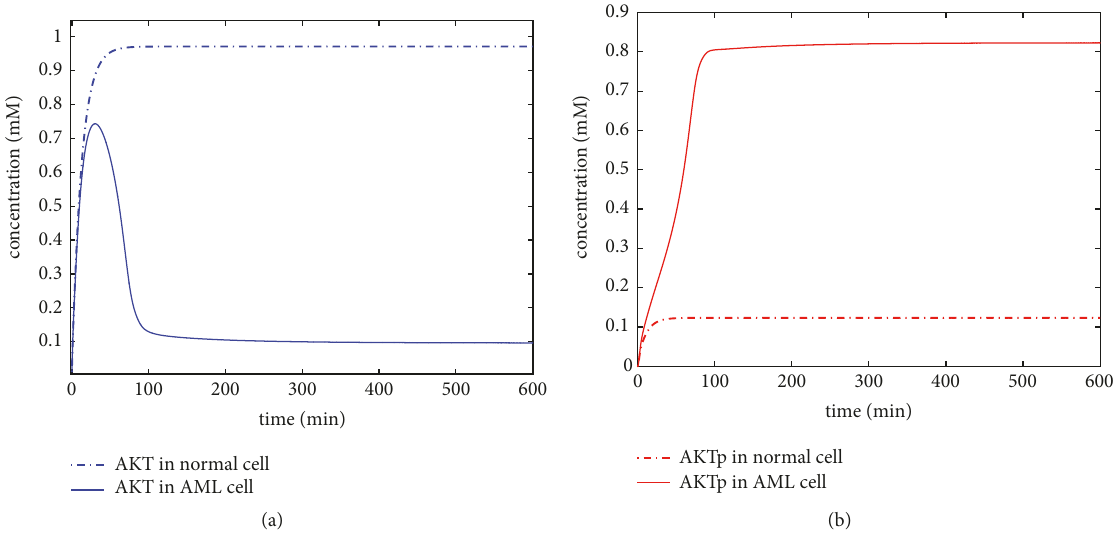
Figure 6: Dynamics of AKT (a) and AKTp (b) in normal and AML cell.